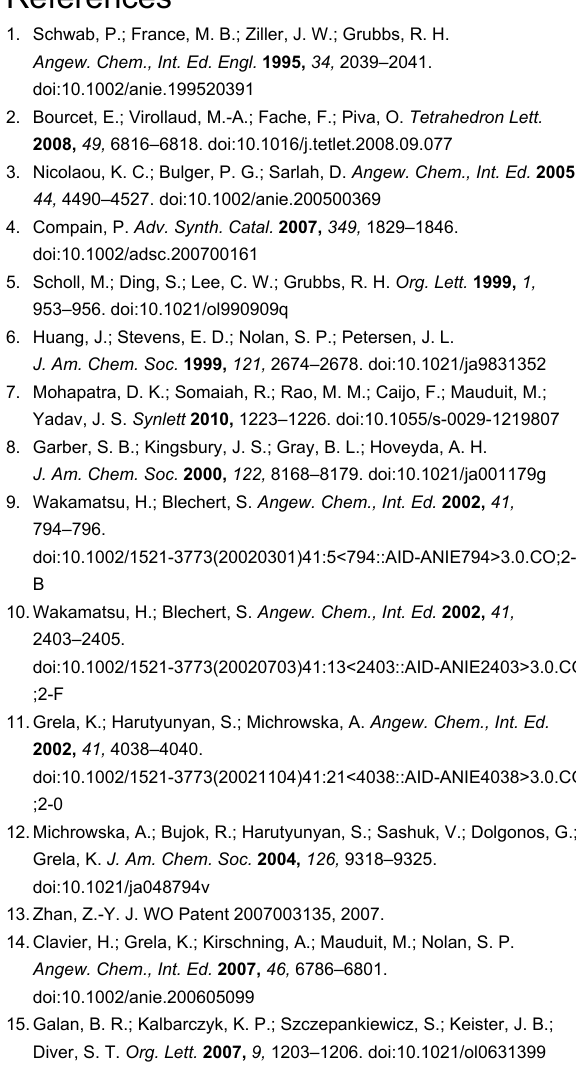
General Procedure for RCM Reactions: A Schlenk tube under an argon atmosphere was filled with the olefin substrate